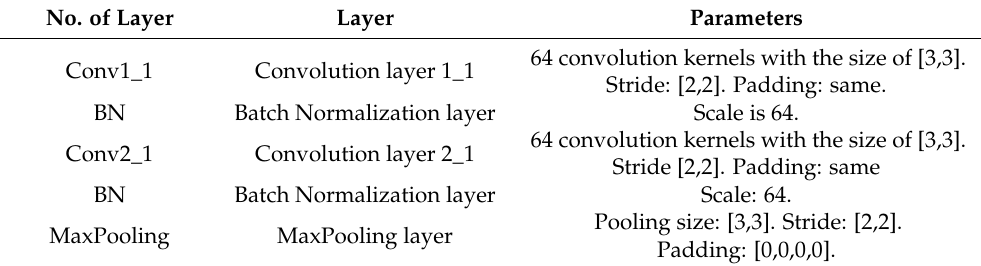
Table 2. Fusion residual block hyperparameters